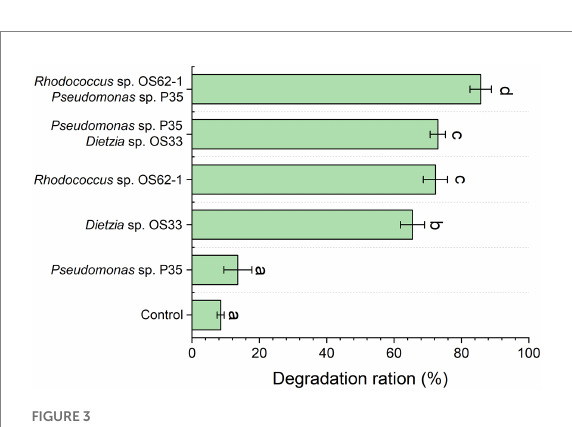
FIGURE 3 The crude oil degradation efficiency of the isolated strains and the constructed consortium was tested for 7 days. Groups sharing different letters (a, b, c) indicate significant differences between two treatments by one-way ANOVA test ( p <